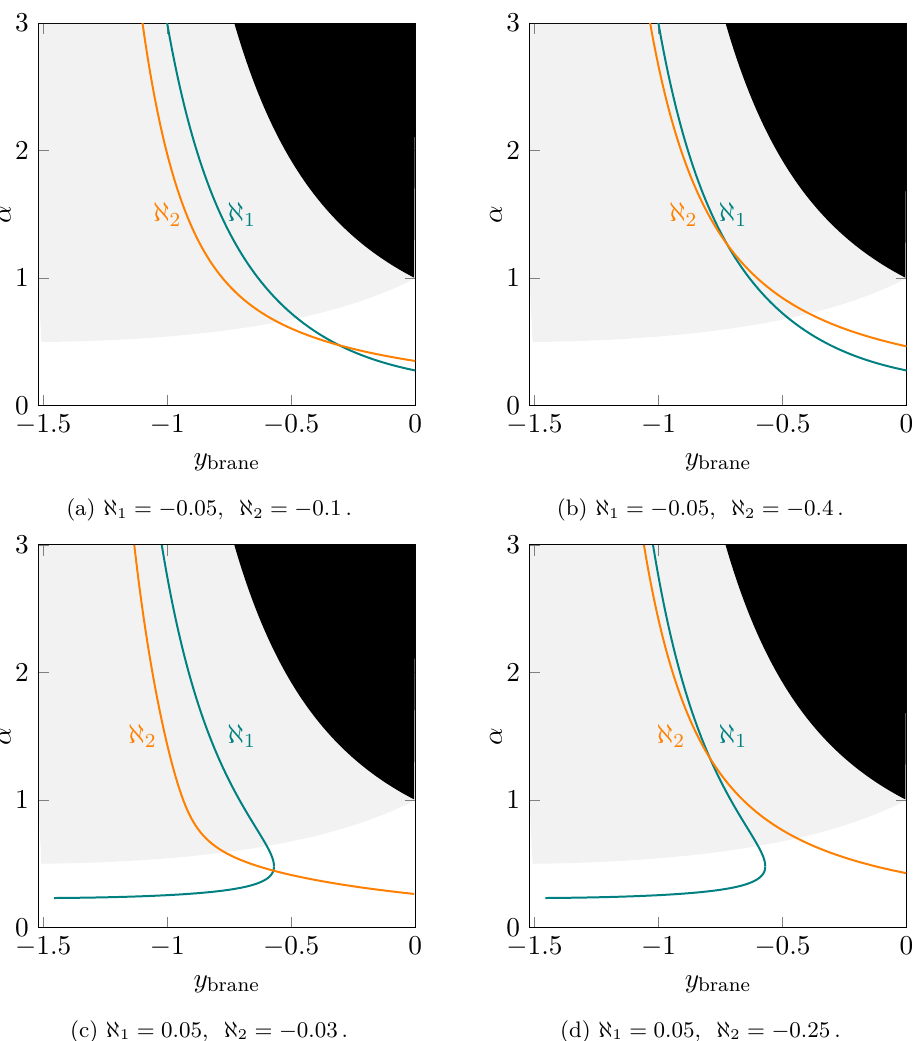
Figure 12 . Contours corresponding to constant values for the invariants in the ( y brane , α ) -plane. If one imposes the stronger (weaker) bound on the JT coupling α , then the physically permissible domain of the brane parameters is given by the white (white + grey) region. One can easily read off the microstate parameters ( y brane , α ) from the location of the intersection